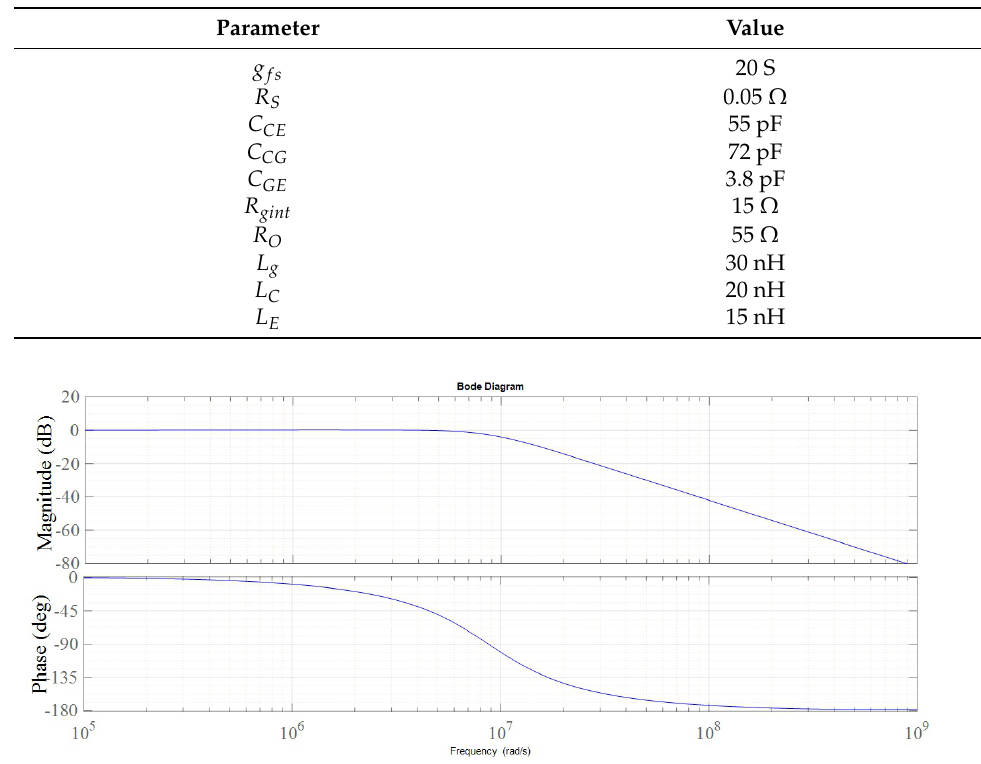
Table 2. The required parameters for the stability analysis.